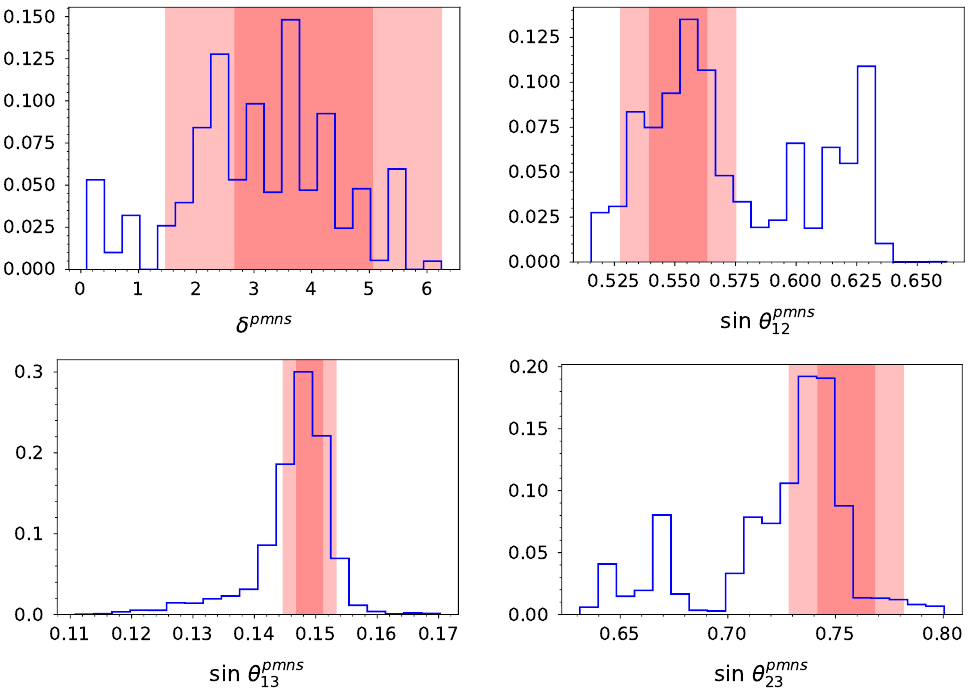
Figure 7 . The PMNS parameters are displayed where the red (light red) region indicating the 1 σ ( 2 σ ) limits. Unlike the CKM parameters, the PMNS shows more variation due to the less stringent experimental constraints.